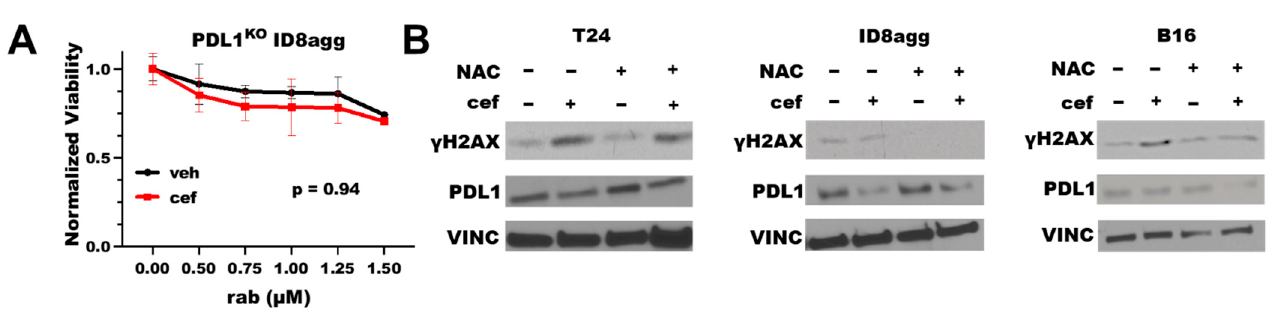
Figure 3. Cefepime-induced DNA damage and sensitivity to DNA-damaging agents is tumor PDL1-dependent with ROS contributions in distinct lines. ( A ) MTT viability in PDL1 KO ID8agg cells treated with 80 µ M cefepime (cef) or DMSO (veh) in combination with indicated concentrations of rabusertib (rab). p value by two-way ANOVA. ( B ) Immunoblots of T24, ID8agg, and B16 cells treated with 80 µ M cefepime and/or 0.5 mM N-acetyl-L-cysteine (NAC) for γ H2AX, PDL1, and loading control vinculin (VINC) (48 h incubation).